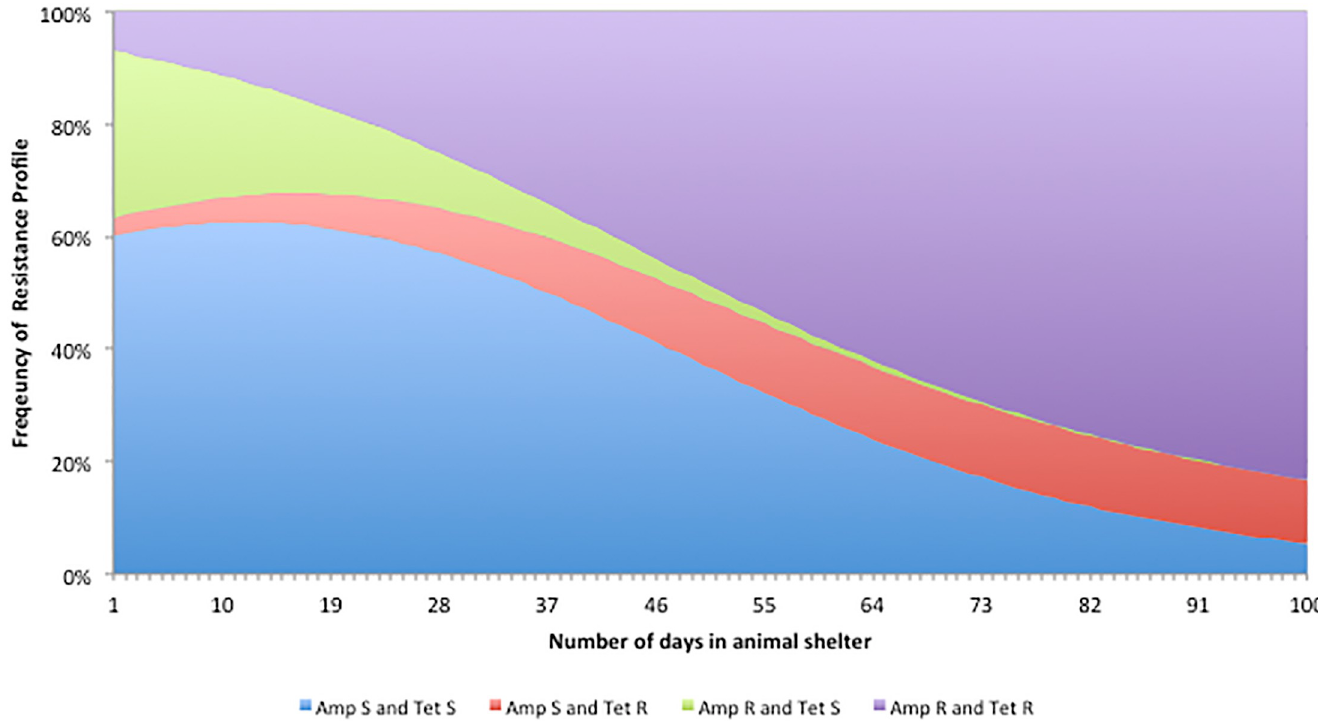
Fig 1. Predicted change in the frequency of E . coli isolates from cats resistant to ampicillin, tetracycline, or both antimicrobials as a function of the numbers of days the cat had resided in the animal shelter.